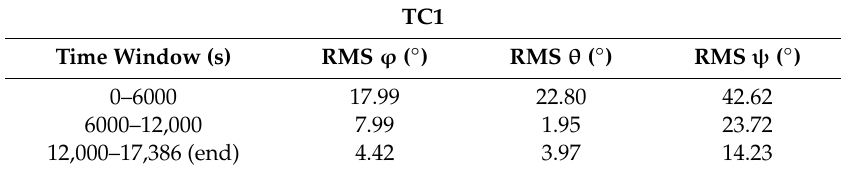
Figure 3. Detail of Figure 2 in the range 0–30 ◦ from 6000 to 17,386 s. Table 3. Root Mean Square of attitude estimation errors for Test Case 1.